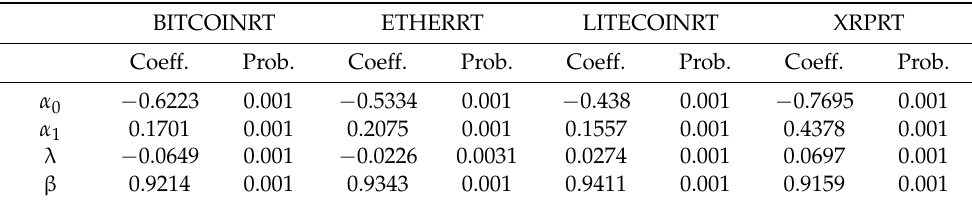
Table 10. EGARCH Model.